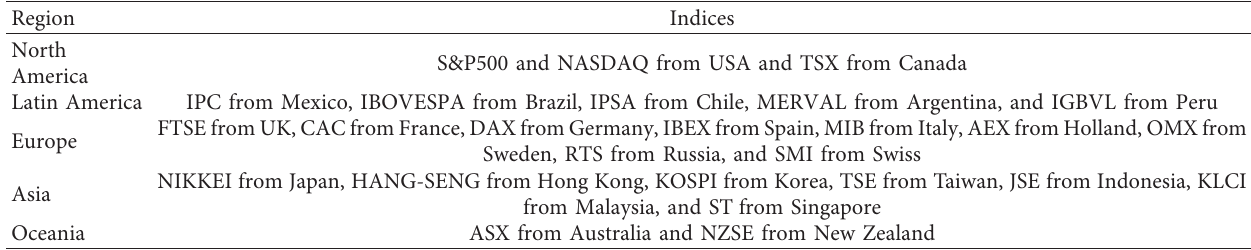
Table 2: Stock country indices by region.